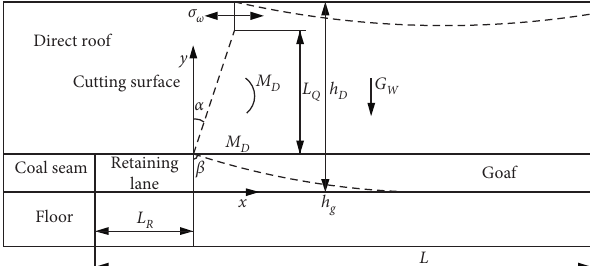
Figure 5: Mechanical model of top roof of cut top height in goaf. ( M D ) rotary bending moment. ( L Q ) roof cutting height. ( h D ) thickness of the immediate roof. ( σ ) tensile stress of the blind ω